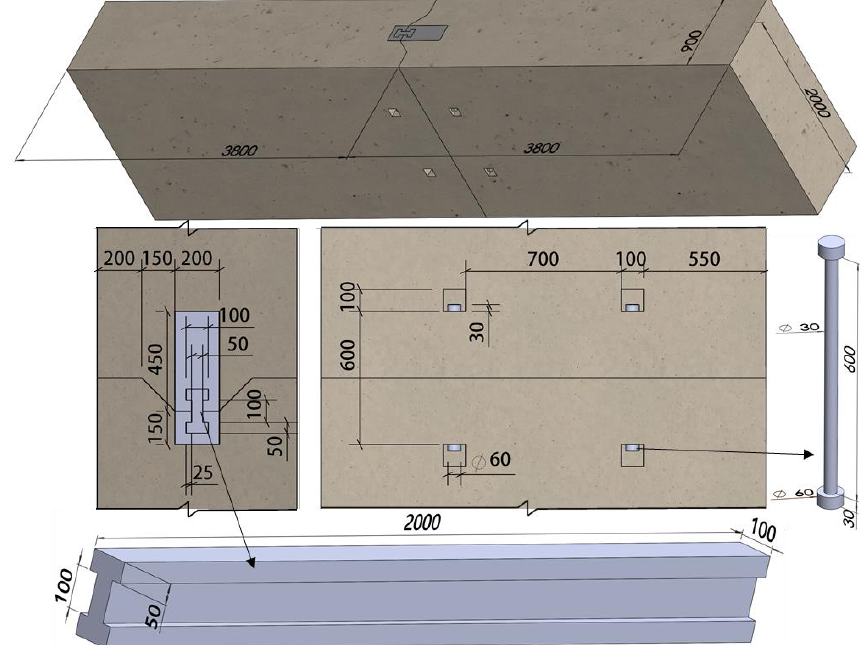
Figure 2. Geometry of the BPJ (dimensions in mm).